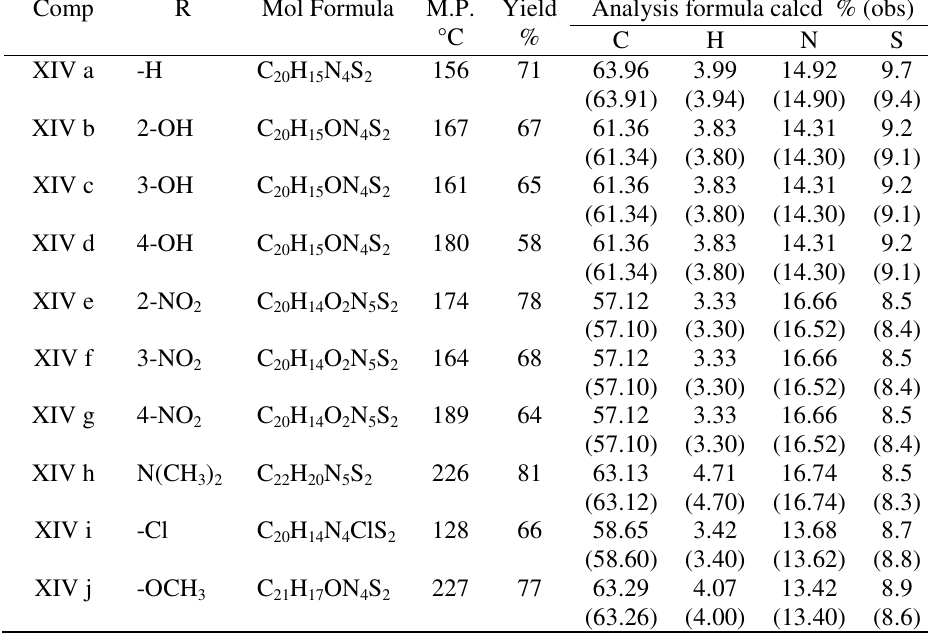
Table 5 .Characterization data of newly synthesized compounds (XIV